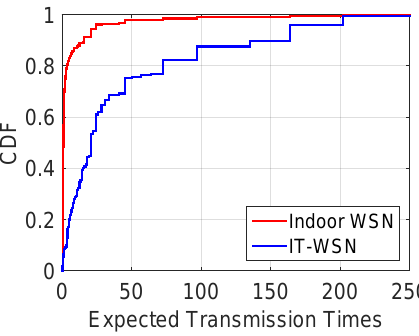
Figure 3. The expected transmission times distribution in an indoor WSN and an IT-WSN in